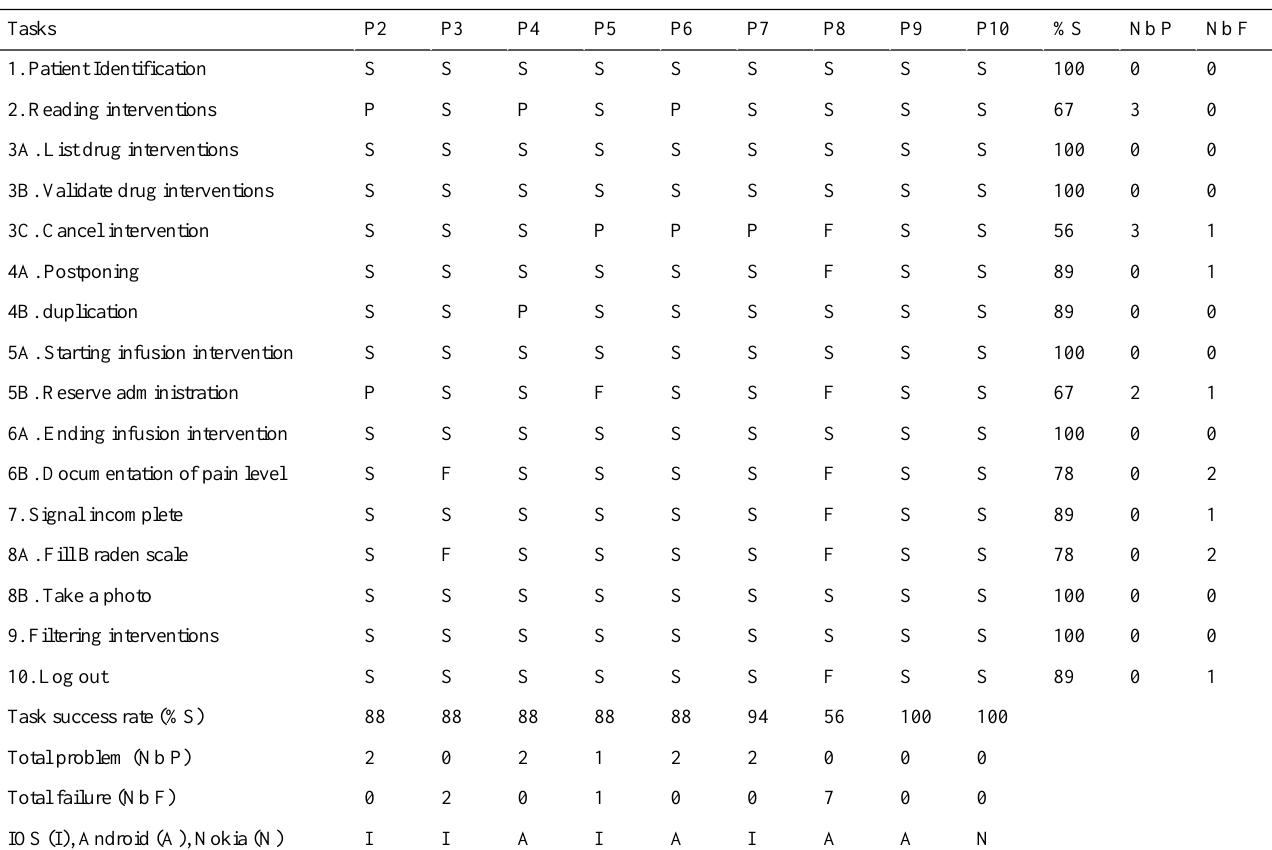
Table 2. Task completion by participants (S=Success, P=Problem,